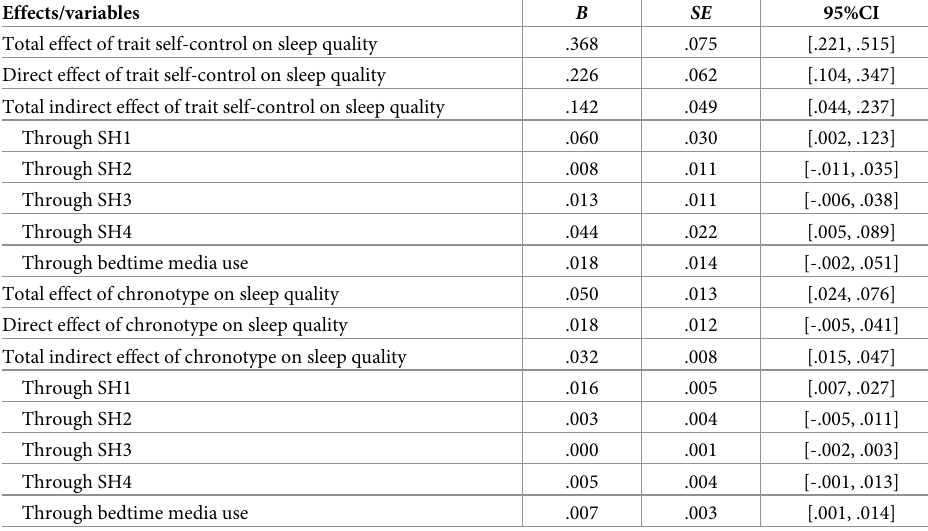
Through bedtime media use .007 Note. B = unstandardized coefficient, CI = confidence interval, SE = standard error. SH1 = pre-sleep stress management, SH2 = sleep timing regularity, SH3 = avoiding sleep-disrupting food or activities, SH4 = keeping a restful sleep